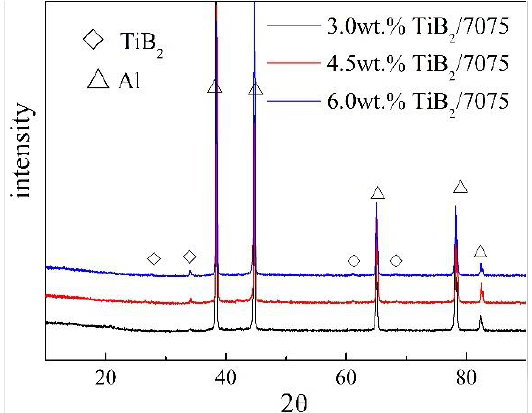
Figure 3. X-ray diffractometer (XRD) pattern of the TiB 2 /7075 aluminum matrix composites.